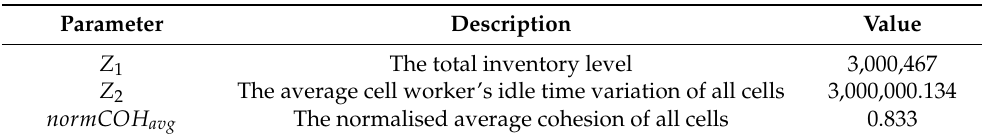
Table 7. Solution obtained by using NSGA-II for the illustrative example.